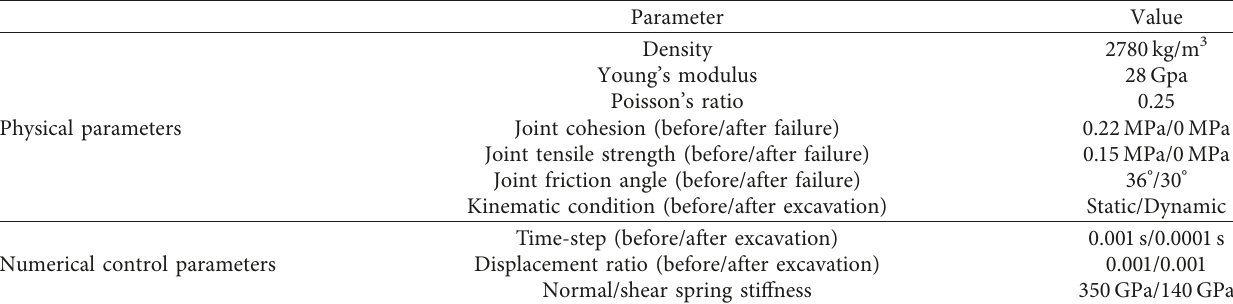
Table 2: Mechanical and numerical control parameters of the models.